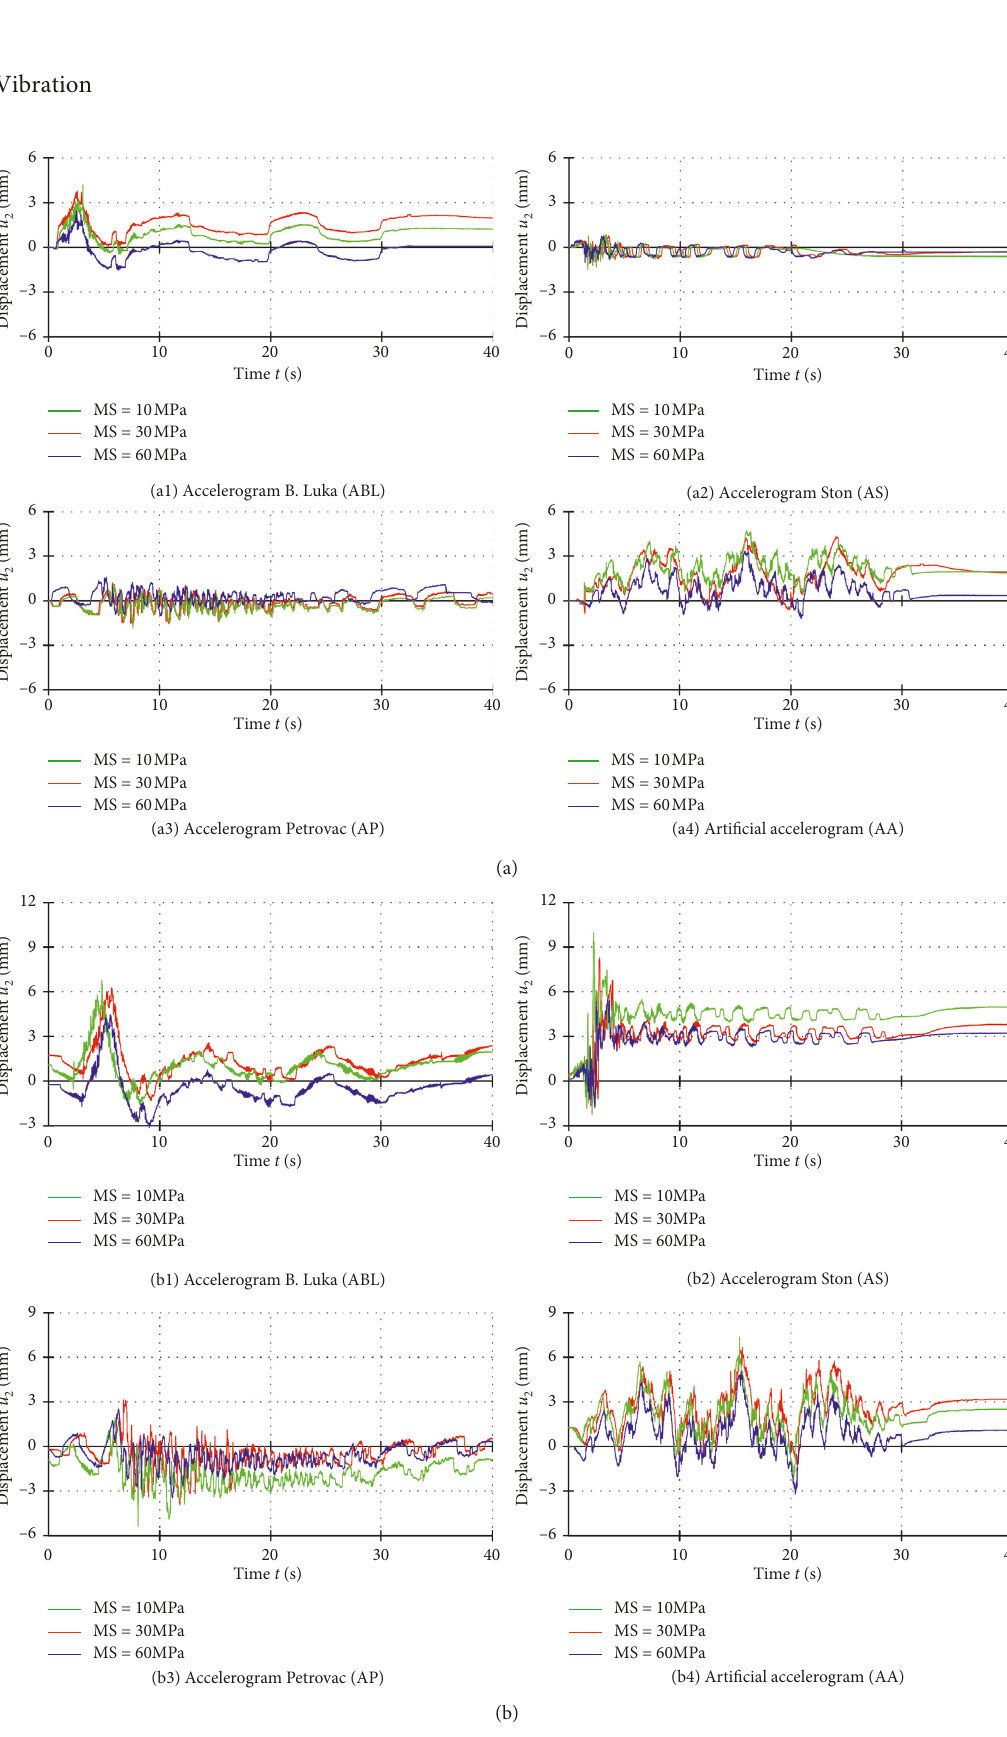
� 0.2g. (b) PGA � 2 . (a) PGA